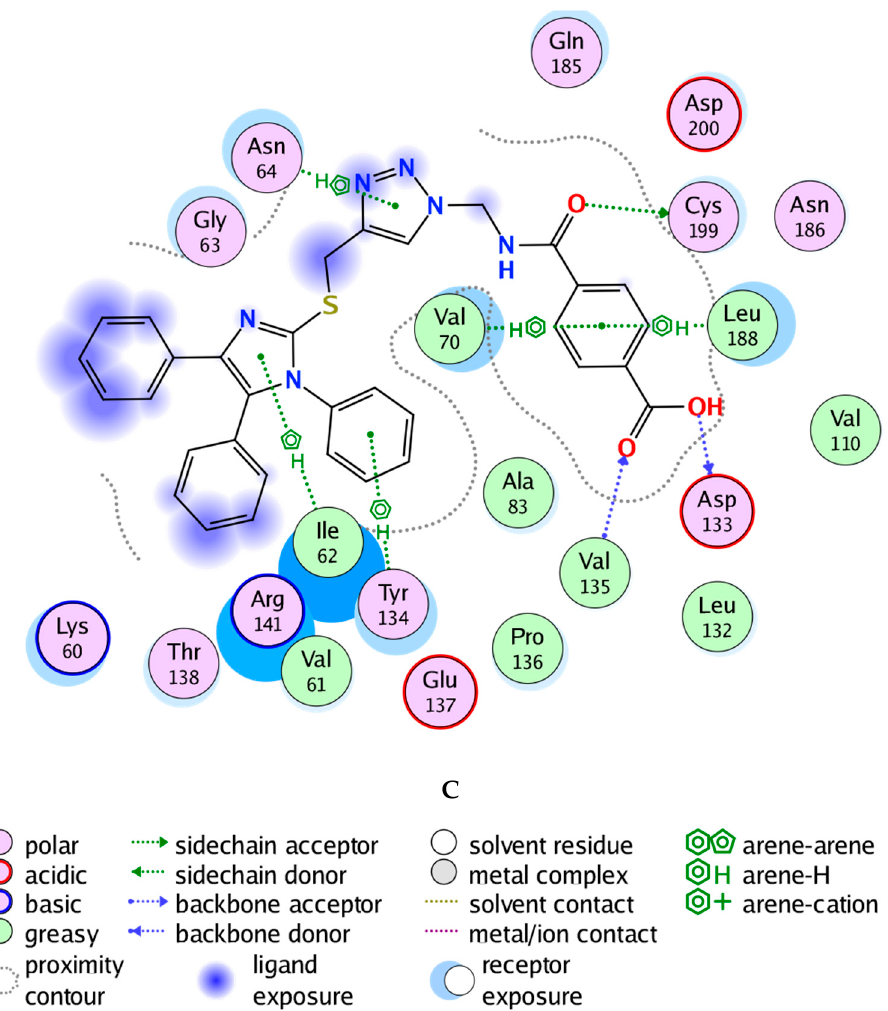
Figure 3. Docking poses of selected compound 4k onto the active site of glycogen synthase kinase-3 beta (GSK-3 β ) (PDB ID: 1UV5). ( A ) Two-dimensional (2D) interaction data and residues of bound ligand 6-bromoindirubin-3 ′ -oxime within the ATP pocket of the target. ( B ) 2D of the compound within the ATP pocket with the corresponding hydrogen bonding and aromatic interactions with residues. ( C ) Three-dimensional (3D) analysis of the target compound 4k mapped to the reference drug, i.e., 6-Bromoindirubin-3 ′ -oxime.